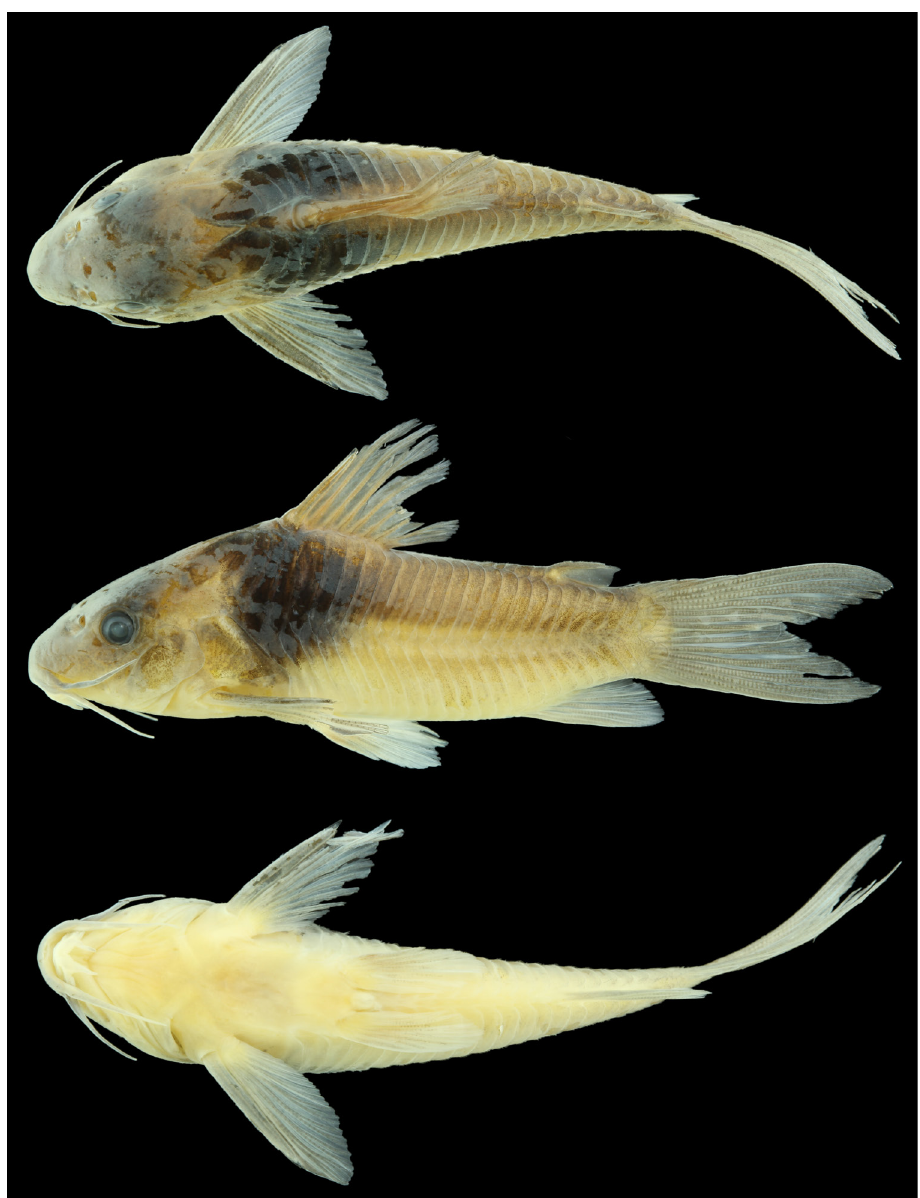
FIGURE 1 | Corydoras maclurei , holotype, MUSM 70671, 37.0 mm SL, Camanti District, Quispicanchi Province, Cusco Region, Peru, small stream tributary to the rio Araza, a bigger affluent of the rio Inambari, itself a tributary to the rio Madre de Dios, rio Madeira